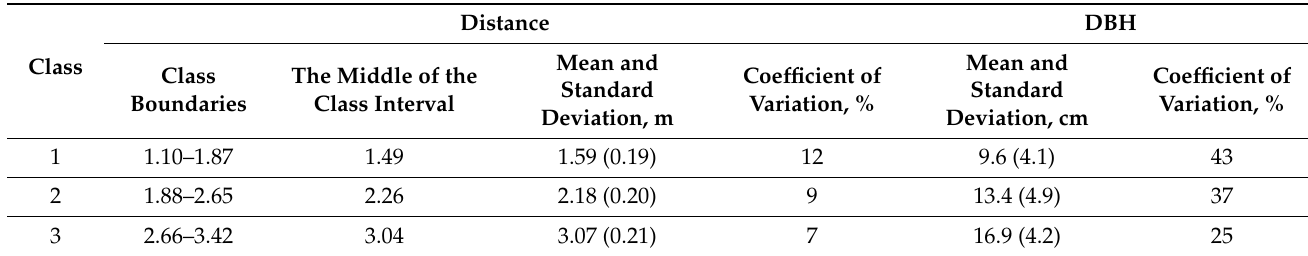
Table 4. Data clustering in the context of the spatial structure factor.